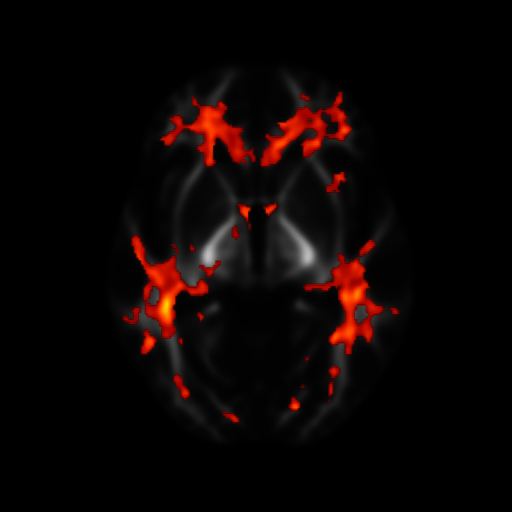
Small vessel disease pathways disrupts subcortical pathways that are important for emotion regulation. Hollocks et al. use brain imaging and statistical modelling to show that white-matter damage is associated with apathy, but not depression, although the latter still has a significant impact on quality of life.